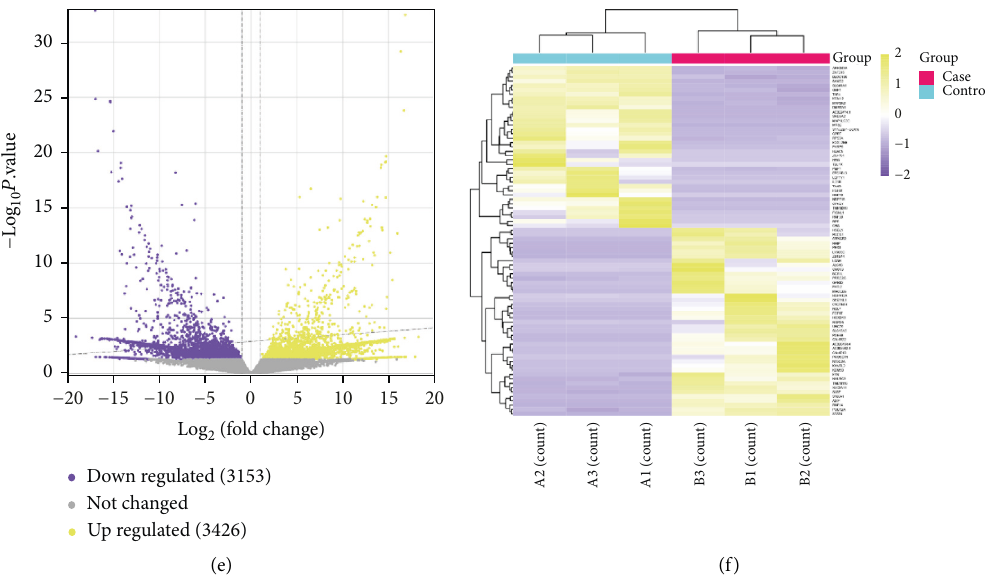
Figure 1: Identification of DElncRNA, DEmiRNA, and DEmRNA induced by β -elemene treatment in CRC. (a)-(b) Volcano map and heat map of lncRNAs. Blue stands for downregulated DEGs, red stands for upregulated DEGs, and gray stands for no significant change in genes. (c)-(d) Volcano map and heat map of miRNAs. Green stands for downregulated DEGs, orange stands for upregulated DEGs, and gray stands for no significant change in genes. (e)-(f) Volcano map and heat map of mRNAs. Yellow stands for downregulated DEGs, purple stands for upregulated DEGs, and gray stands for no significant change in